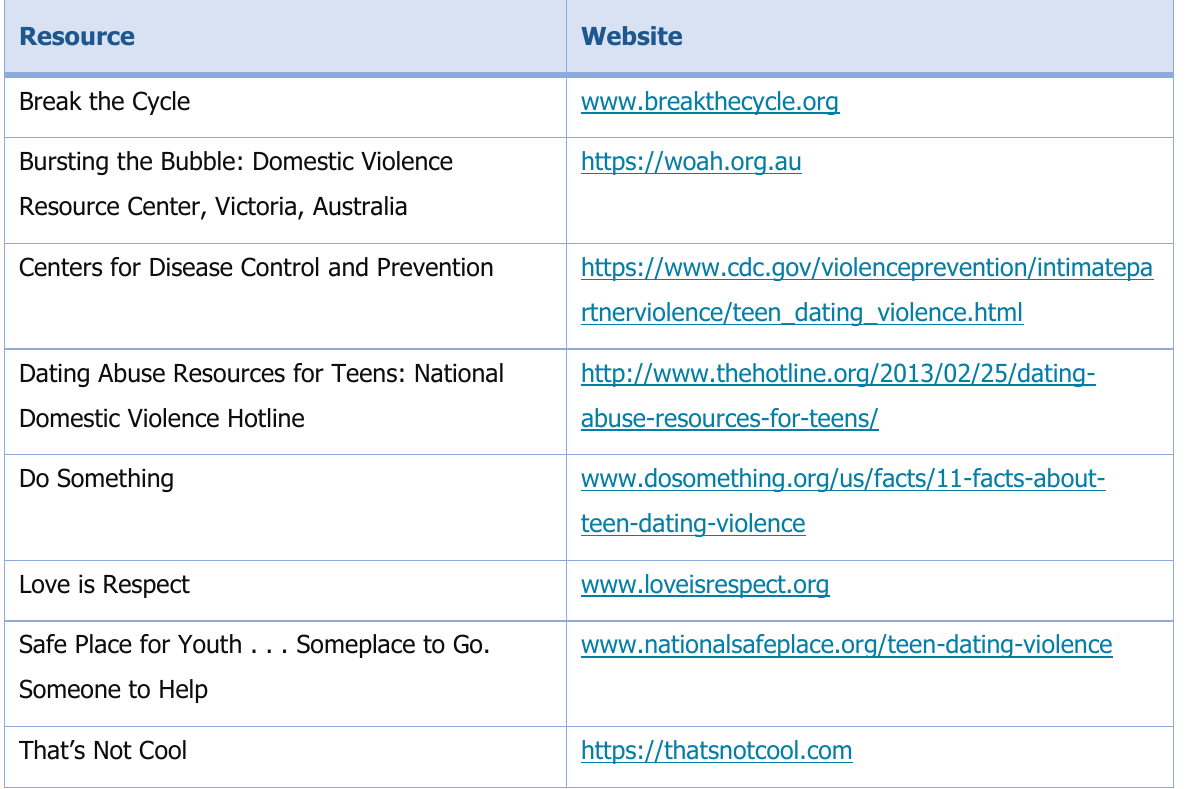
Table C2. Domestic Violence Resources for Youth and Teens